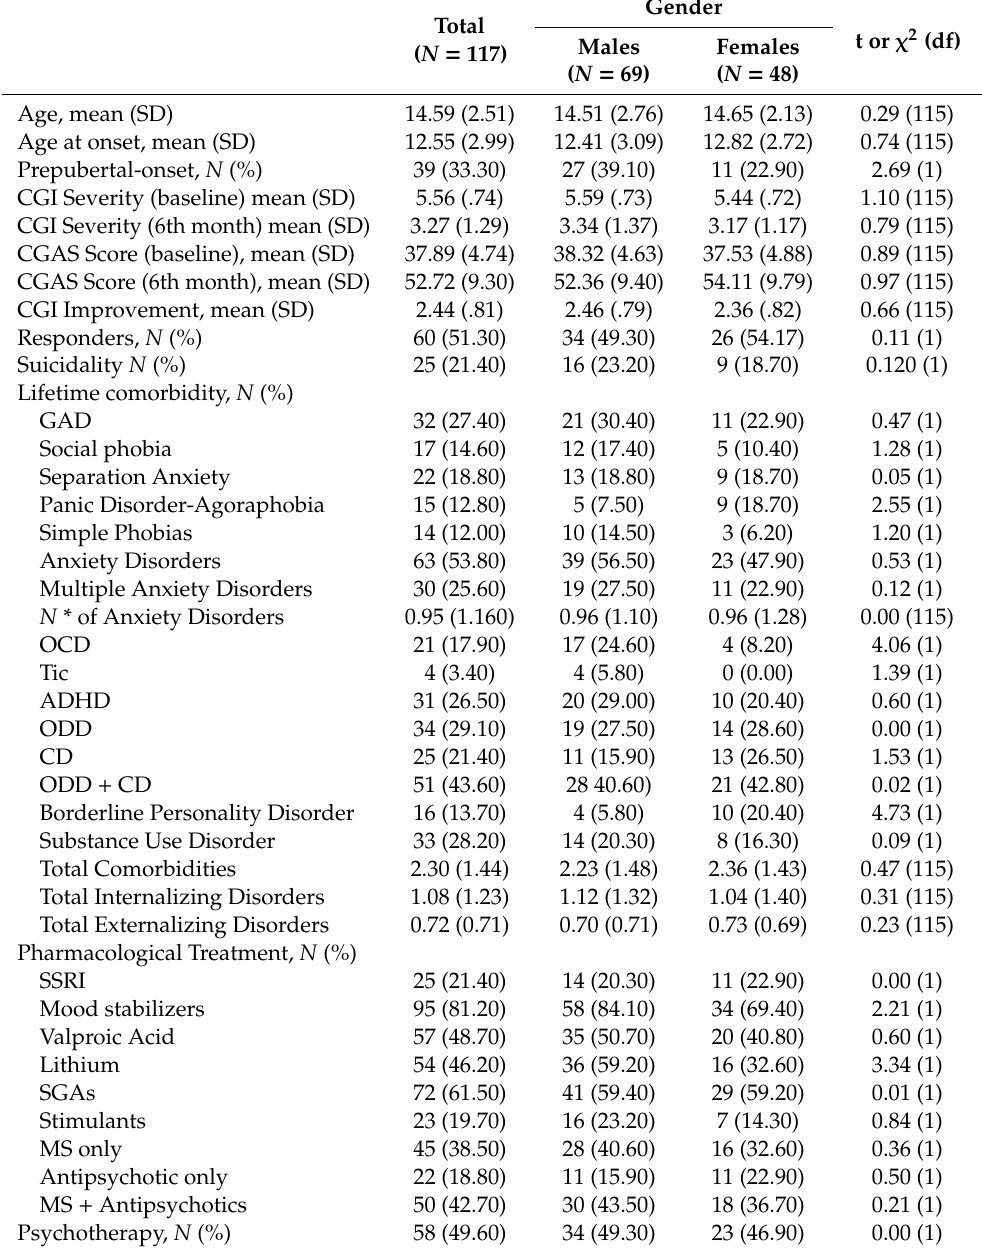
Table 1. Clinical characteristics of the